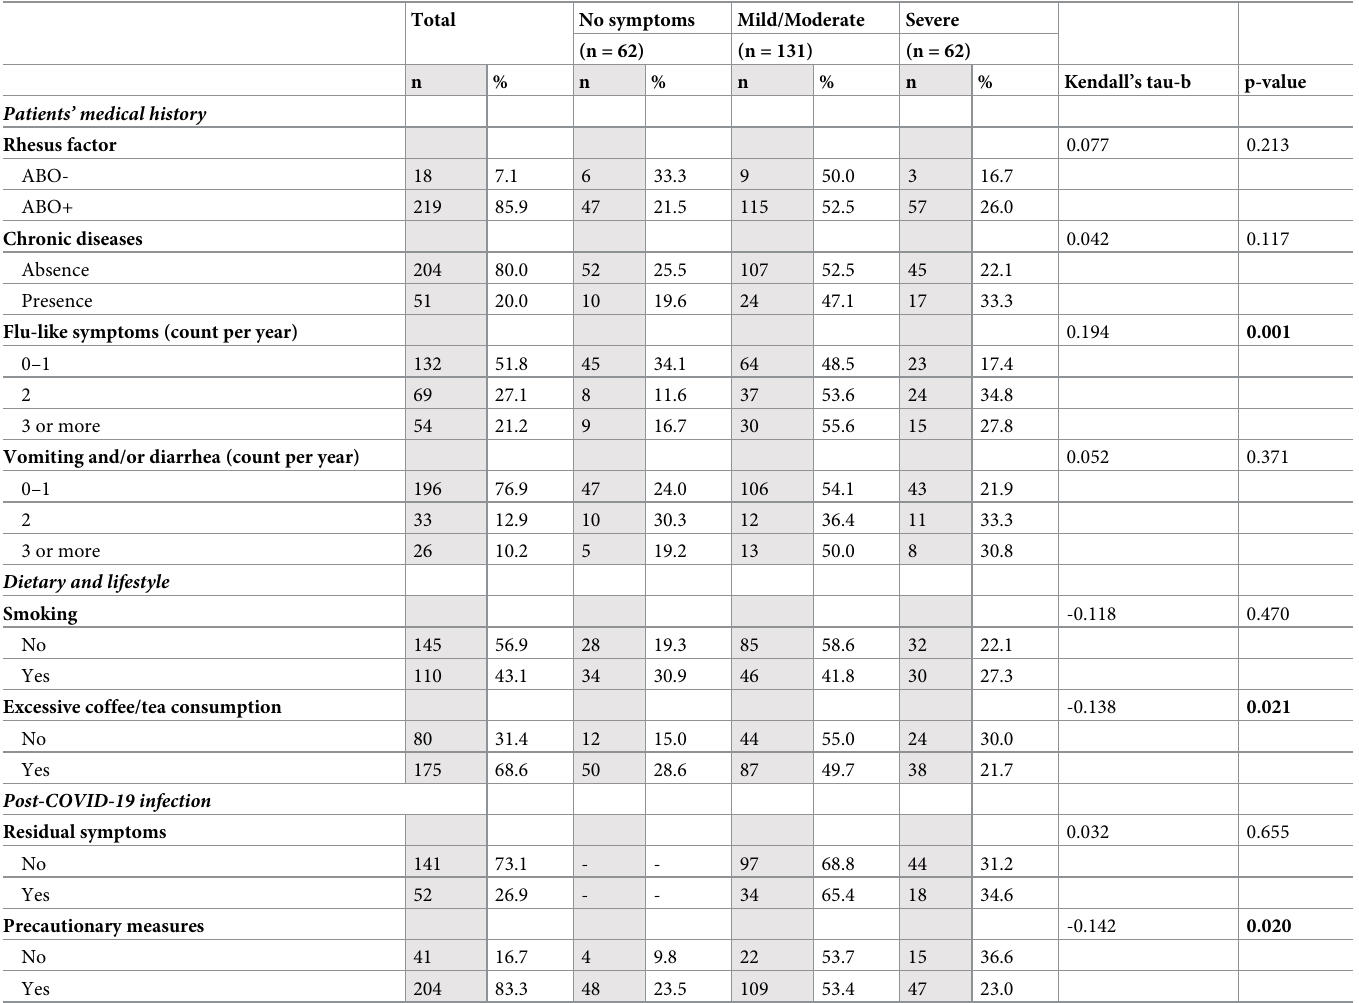
Table 4. Description of other variables and their association with COVID-19